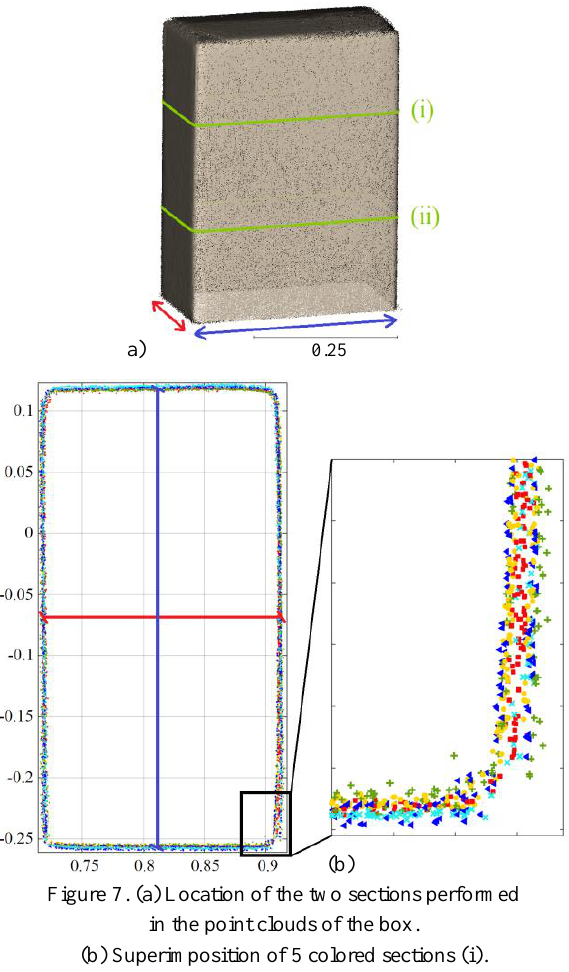
Figure 7. (a) Location of the two sections performed in the point clouds of the box. (b) Superimposition of 5 colored sections (i). The surveyed distances are in blue (length) and red